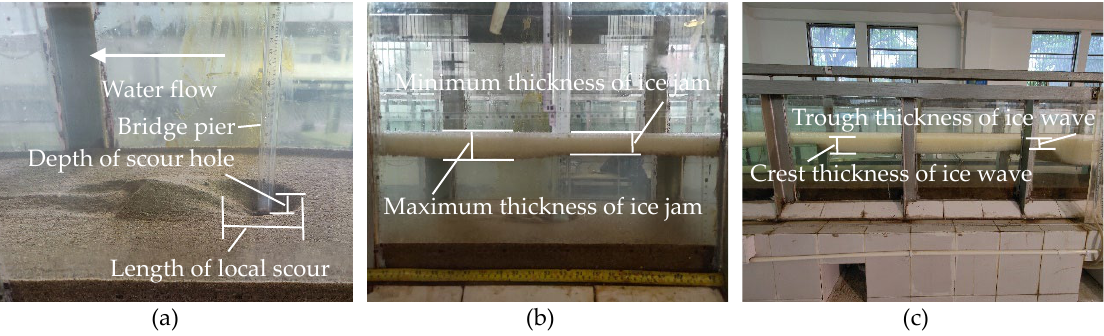
Figure 2. Scour hole at the pier under an ice jam and associated variables. (( a ): scour hole with point measurement; ( b , c ): points for measuring ice jam thickness).